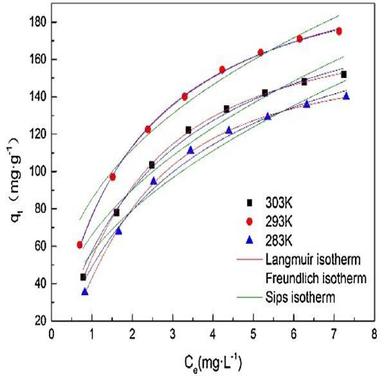
Adsorption isotherms.